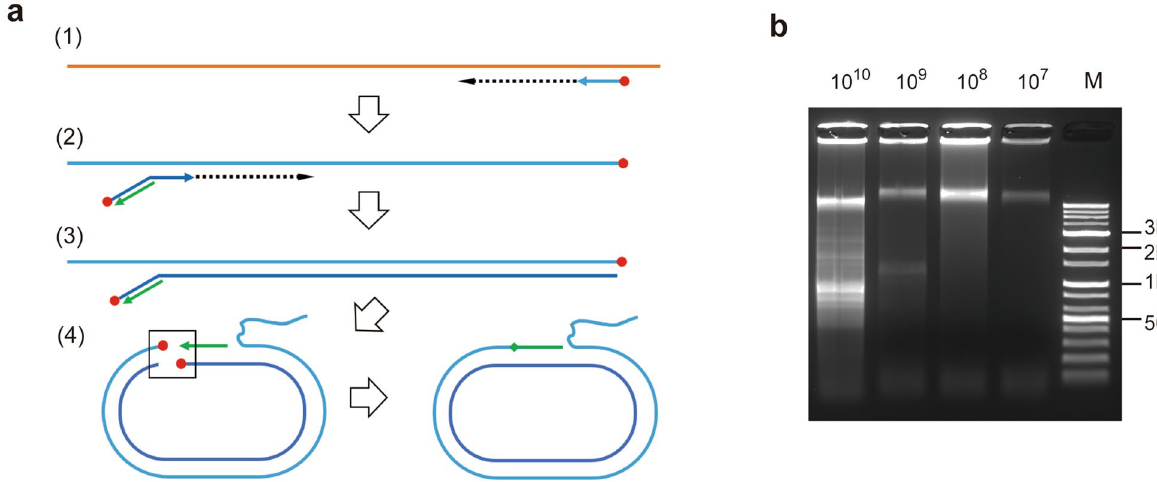
Figure 4. Ligase-CREA. ( a ) Schematic process of ligase-CREA. 5 ′ -phosphate groups are designated with red circle. Ligation target site is marked with a box. ( b ) Sensitivity of ligase-CREA was evaluated with 1/10 serial- diluted templates from 3.1 × 10 10 to 3.1 × 10 7 copies. Lower-sized target band of 3.1 × 10 10 copies template input sample is due to migration disturbance of incorporated SYBR green I since the ligase-CREA product with the same input template showed the same sized band as the product of Cre mediated CREA in the post-stained gel (Supplementary Fig. 10b). M